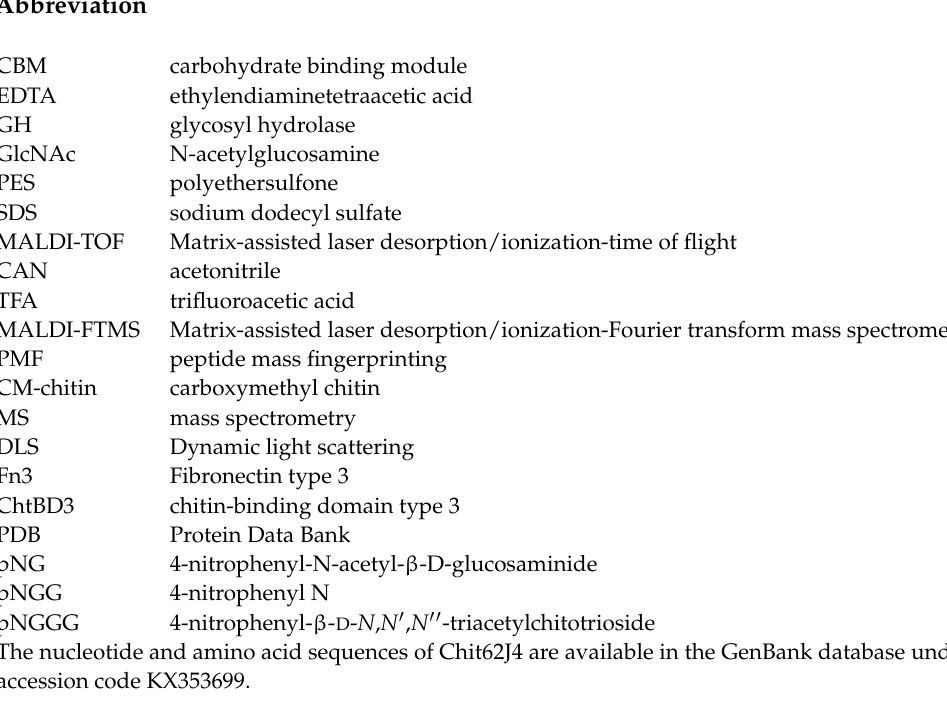
Chit62J4. Figure S6: Graphs of pH and temperature dependence of crChit62J4 activity and pH dependence of rChit62J4cat activity. Figure S7: Proposed domain structure of